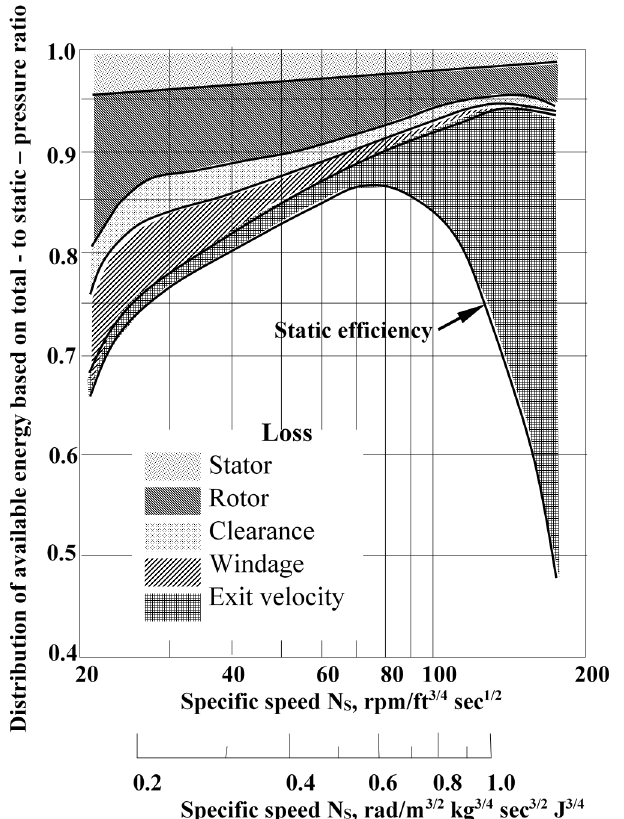
Figure 6. Distribution of losses along envelope of maximum total-to-static efficiency [14 ‒